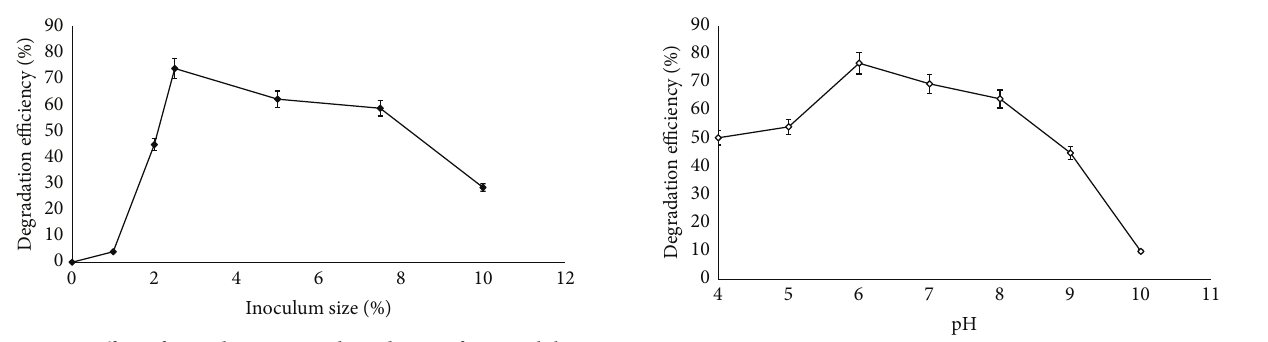
Figure 5: Effect of pH on degradation efficiency of corn cob by S. carnis (error bars represent mean values and standard deviation of triplicate